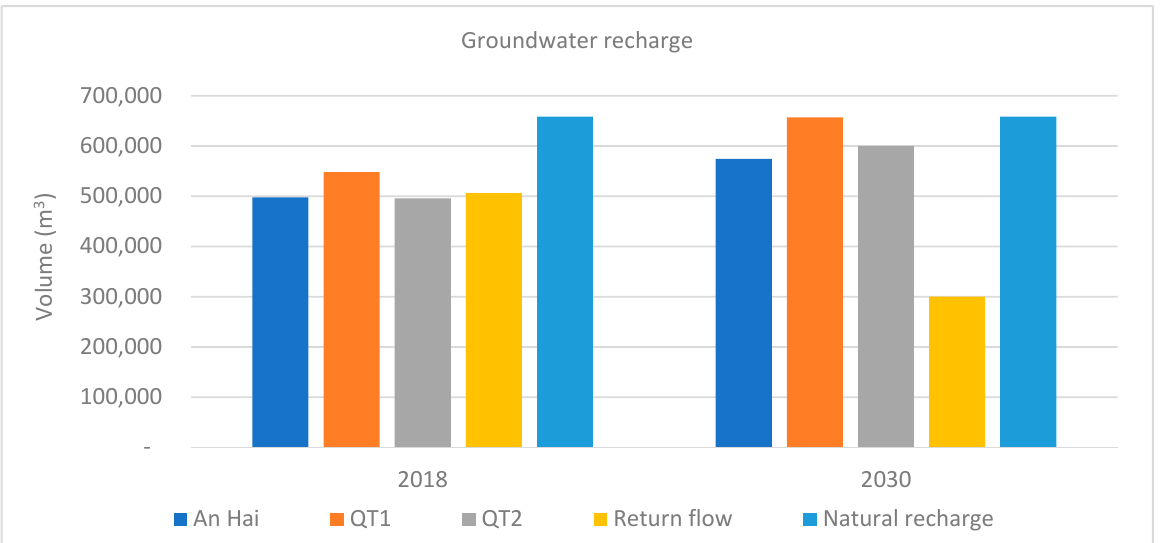
Figure 7. Groundwater recharge in Con Dao Island in 2018 and 2030.